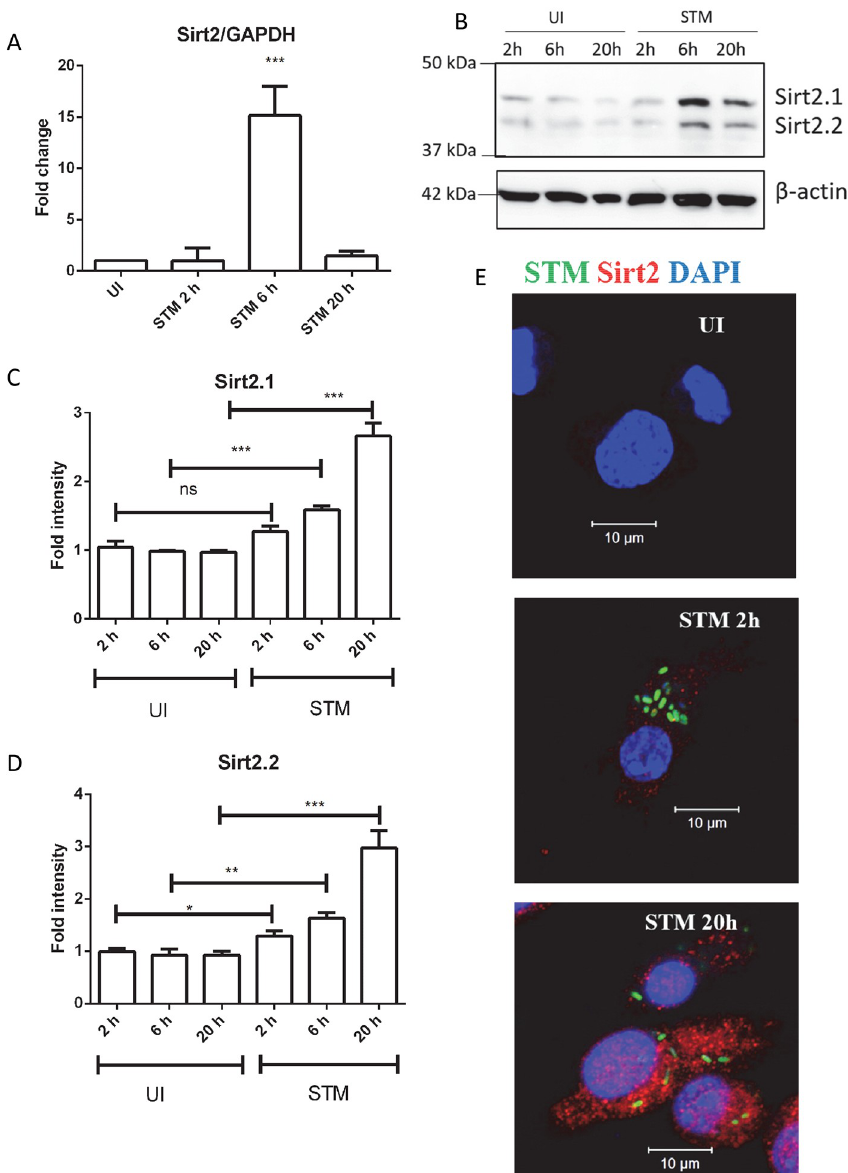
Fig 1. Salmonella infection upregulates SIRT2 expression in DCs. A. qPCR analysis of SIRT2 expression in DCs at indicated time post infection. GAPDH was used as an internal control. (UI- Uninfected, STM- Salmonella Typhimurium infected) (Data are presented as mean ± SEM of 3 independent experiments). B. Representative immunoblot of SIRT2 in DC at indicated time post- infection. (UI- Uninfected, STM- Salmonella Typhimurium infected). C. Densitometry analysis of SIRT2.1 band at indicated time post- infection. (UI- Uninfected, STM- Salmonella Typhimurium infected) (Data are presented as mean ± SEM of 3 independent experiments). D. Densitometry analysis of SIRT2.2 band at indicated time post- infection. (UI- Uninfected, STM- Salmonella Typhimurium infected) (Data are presented as mean ± SEM of 3 independent experiments). E. Representative immunofluorescence image of DCs showing SIRT2 expression at 20 h post infection (UI- Uninfected, STM- Salmonella Typhimurium infected) (Green color- Salmonella Typhimurium, Red color- SIRT2, Blue color- DAPI) (unpaired two tailed Student’s t- test, p- value, ��� < 0.0001, �� < 0.001, � < 0.01).